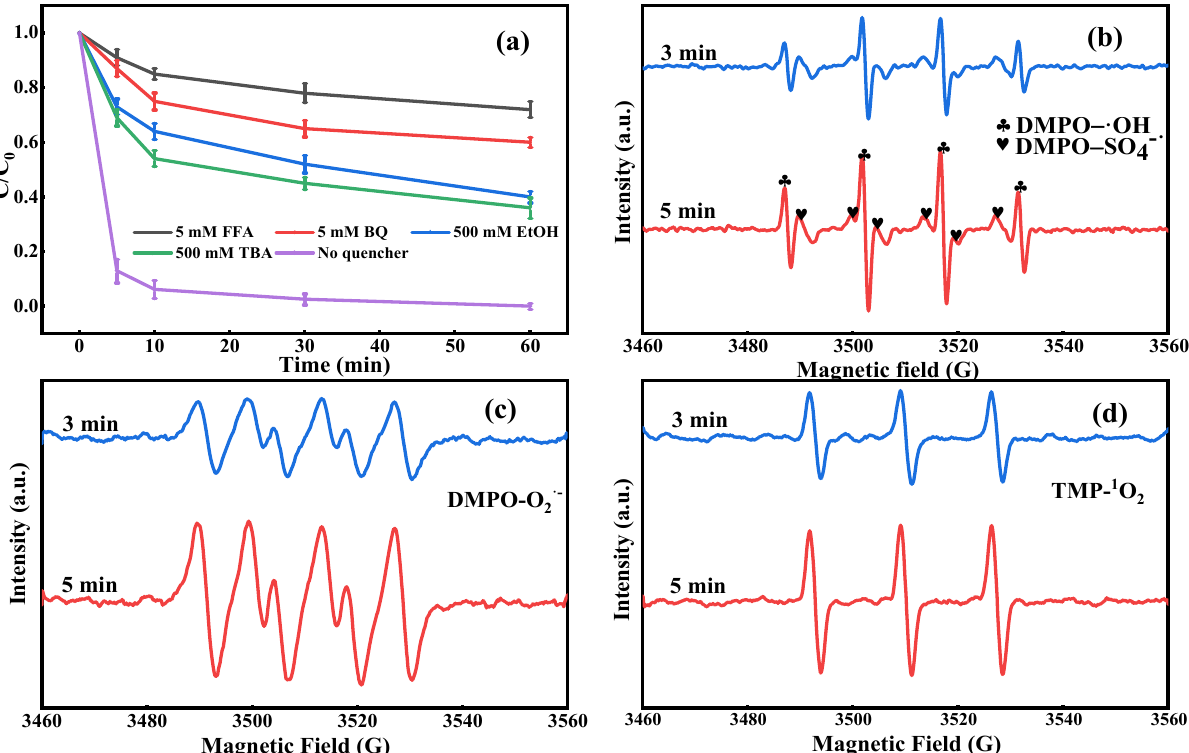
Figure 7. ( a ) Effect of different scavengers on the degradation of CIP and EPR spectra of